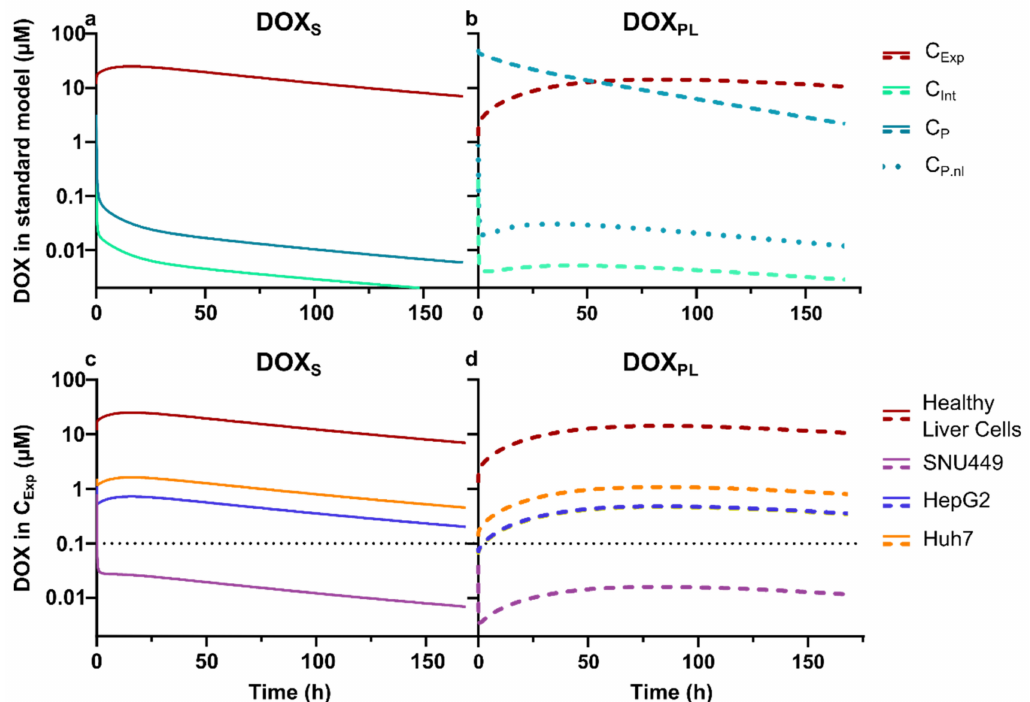
Figure 5. The results from the physiologically based simulation. ( a , b ) Simulated cellular exposure (C Exp , a combination of the interstitial and intracellular concentration for liver cells), interstitial concentration in the liver (C Int ), and plasma concentration (C P ) of DOX when given as DOX PL and DOX S . Treatment was set to a dose of 50 mg/m 2 for both treatments, with C Exp in red, C Int in green and plasma concentration in teal, for both DOX S (full lines) and DOX PL (dotted lines) as well as the non-liposomal DOX found in plasma after DOX PL treatment (C P.nl , circles). ( c , d ) C Exp is modelled based on experimental IC UR for the PLC cells, with healthy liver cells (red), SNU449 (purple), HepG2 (blue) and Huh7 (orange). This is shown for DOX S treatment ( a , c ) and DOX PL treatment ( b , d ) at a dose of 50 mg/m 2 . The dotted line symbolizes the therapeutic zone, which was defined from the cell viability investigations as the concentration range above the lowest concentration with detectable effect (~10%). Simulations were performed with PBPK models for DOX S and DOX PL , as described in Section 2.9, adopting a typical male individual (30 years old, 73